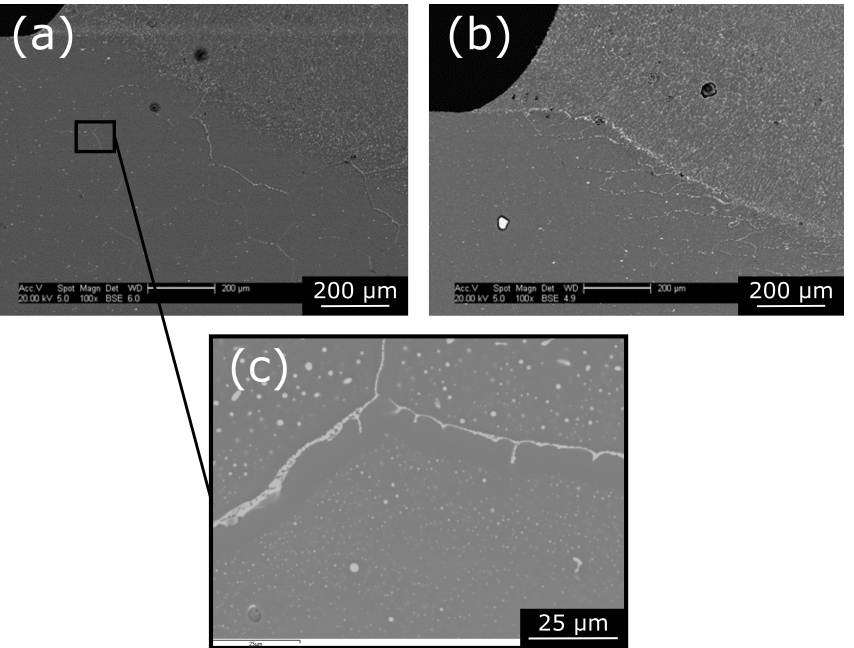
Figure 5. SEM images of the PMZ in the ( a ) 2139 and ( b ) 2050 substrates at low magnification and in the ( c ) 2139 substrate at higher magnification.